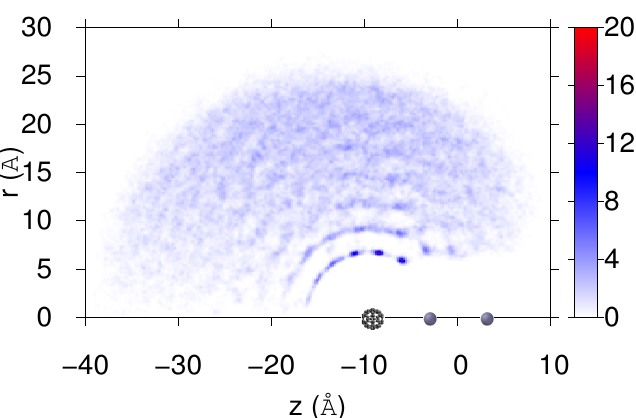
Figure 10. Final He density distribution ( × 10 − 3 Å − 2 ) in cylindric coordinates for M = 10 when considering an initial relative velocity v 0 = 239.8 m/s. Positions of Cs 2 and C 60 impurities are also